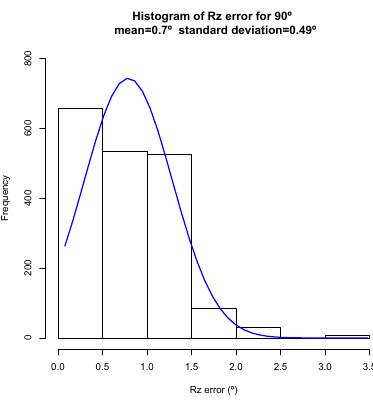
Figure 30. Histogram of R z for 90 ◦ of rotation. The curve in blue is the curve estimated by R as the Gaussian curve that is closest to the obtained data.